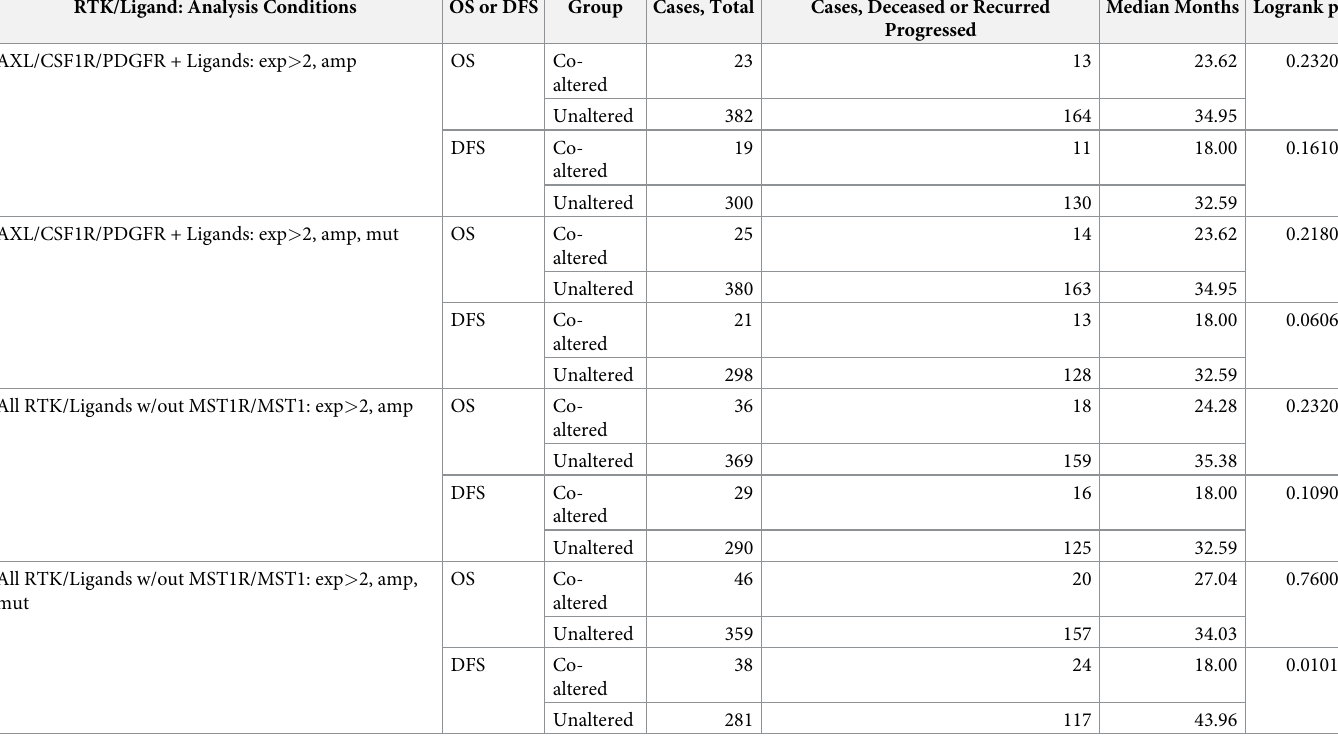
Table 3. Median months OS and DFS for combined significantly concurrent potentially oncogenic alterations (RNASeq V2 > 2-fold and/or gene amplification and/or mutation as noted) for RTKs and cognate ligands in BCa TCGA dataset (n = 408) [22]. RTK/Ligand: Analysis